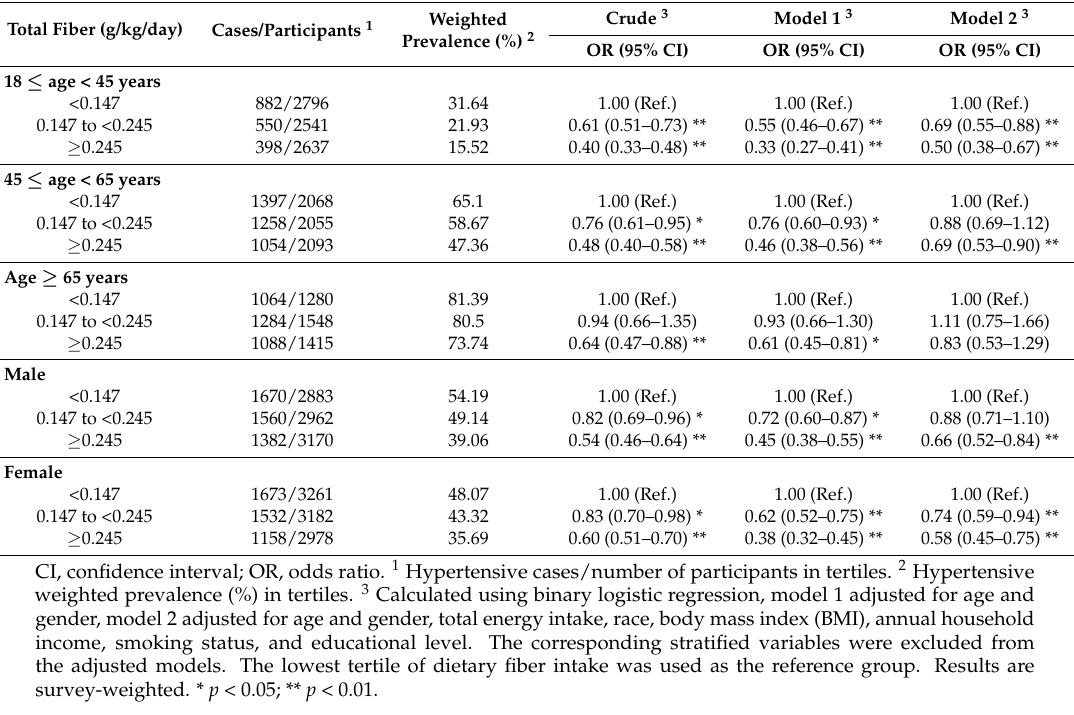
Table 3. Weighted ORs and 95% CIs for hypertension according to tertiles of total fiber intake, stratified by age and gender, NHANES 2007–2014, adults aged ≥ 18 years.